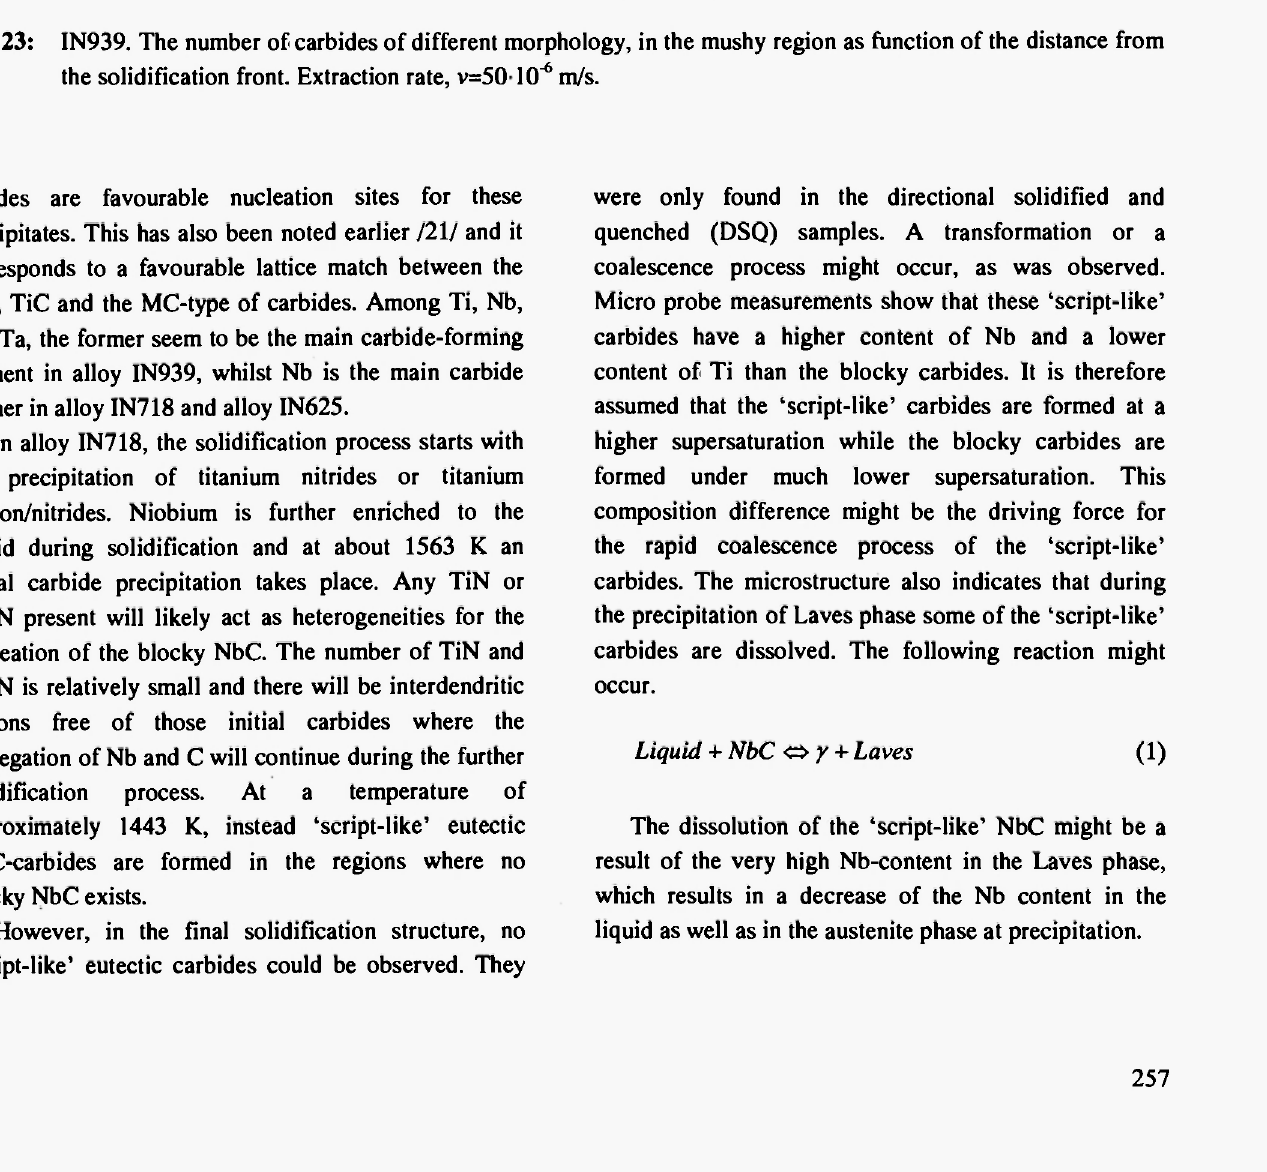
Fig. 23: IN939. The number of carbides of different morphology, in the mushy region as function of the distance from the solidification front. Extraction rate, v^OlO" 6 m/s.